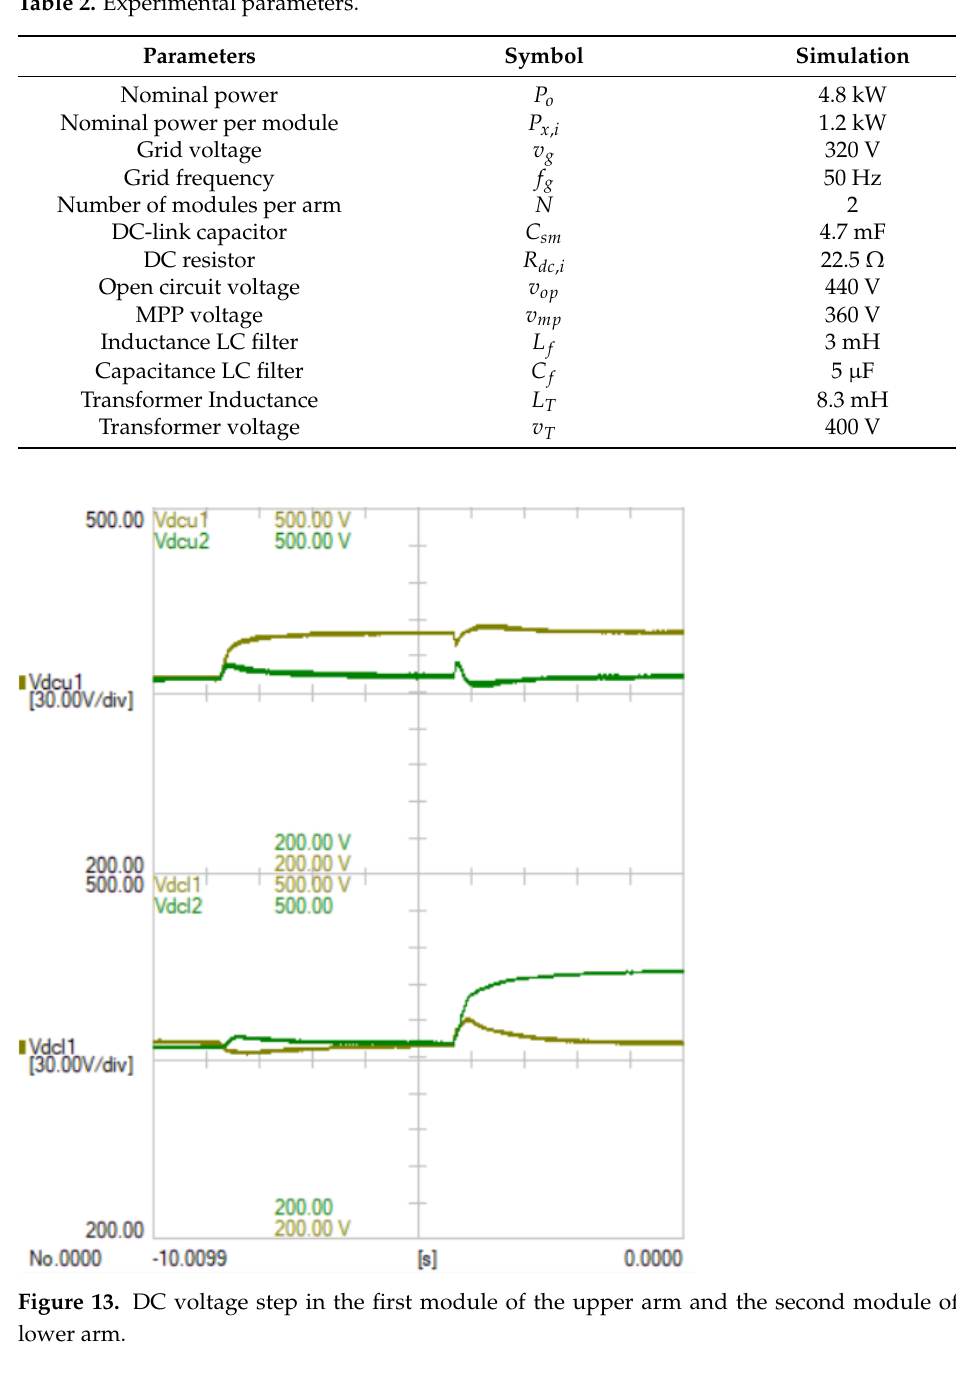
Table 2. Experimental parameters.